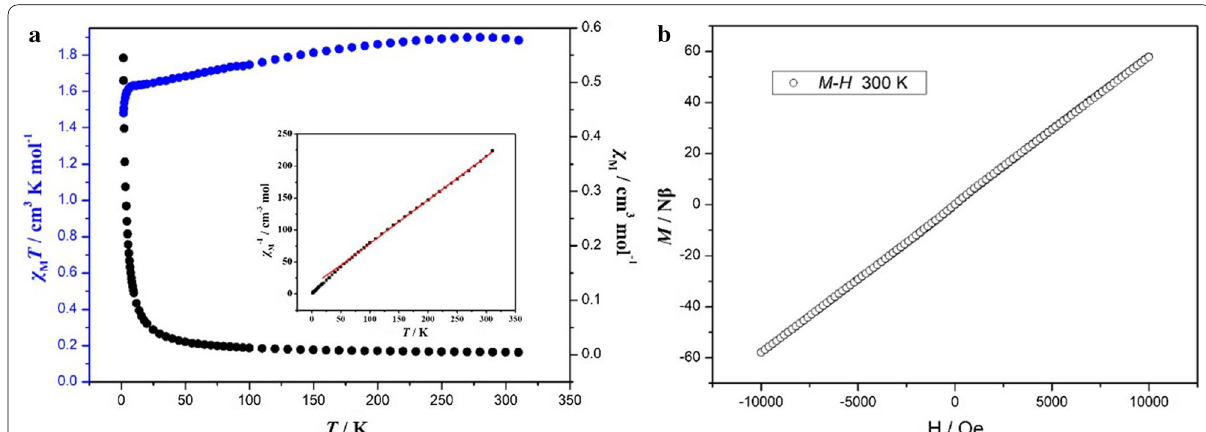
Fig. 17 a 1/ χ in the range of 1.8–300 K in 100 Oe for EuCrMo 6 . Red solid line corresponds to the best fit; b M–H curve at 300 K of EuCrMo